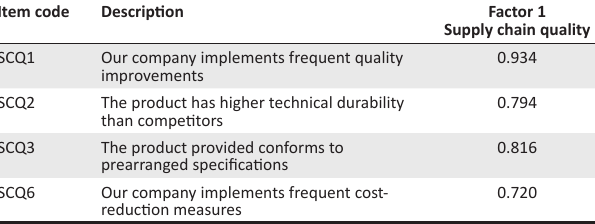
TABLE 5: Two-factor rotated structure for the business performance scale. TABLE 4: Unidimensional factor structure for the supply chain quality